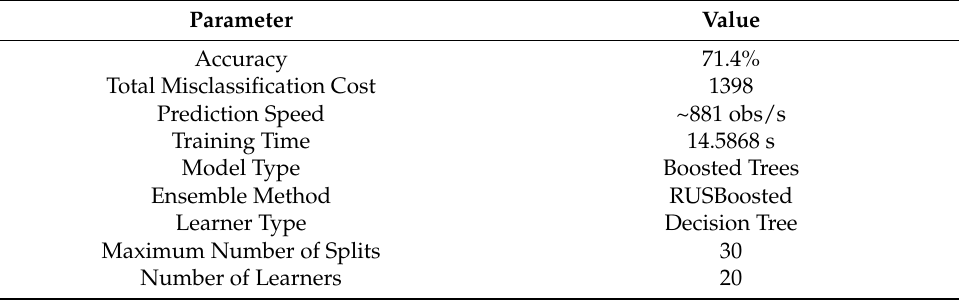
Table 6. Ensemble RUSBoosted tree characterization.